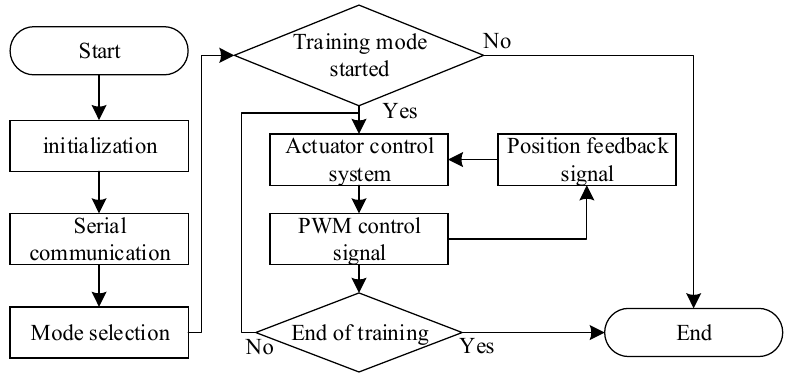
Figure 8. Flow chart of control system.